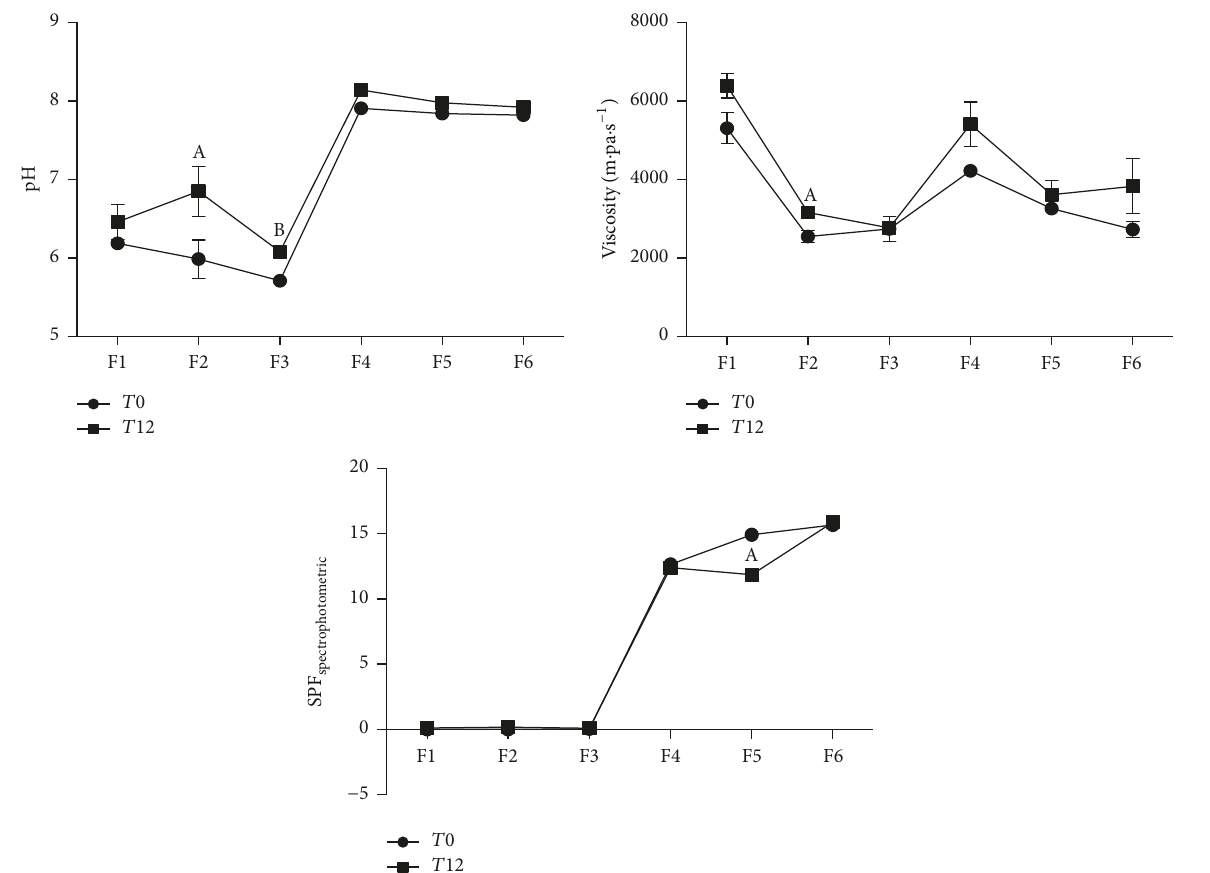
Figure 3: Evaluation of pH, viscosity (m ⋅ Pa ⋅ s −1 ), and Sun Protection Factor (SPF spectrophotometric ) of photoprotective formulations (F1–F6) before ( 𝑇 0) and after ( 𝑇 12) the preliminary stability study. Results are expressed as mean ± SD, where A (𝑝 < 0.05 𝑇 0 versus 𝑇 12) and B (𝑝 < 0.05 𝑇 0 versus 𝑇 12), according to Student’s 𝑡